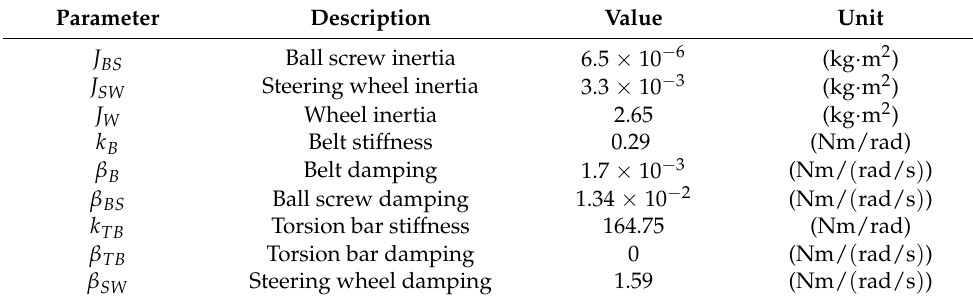
Table 4. Identified parameters.